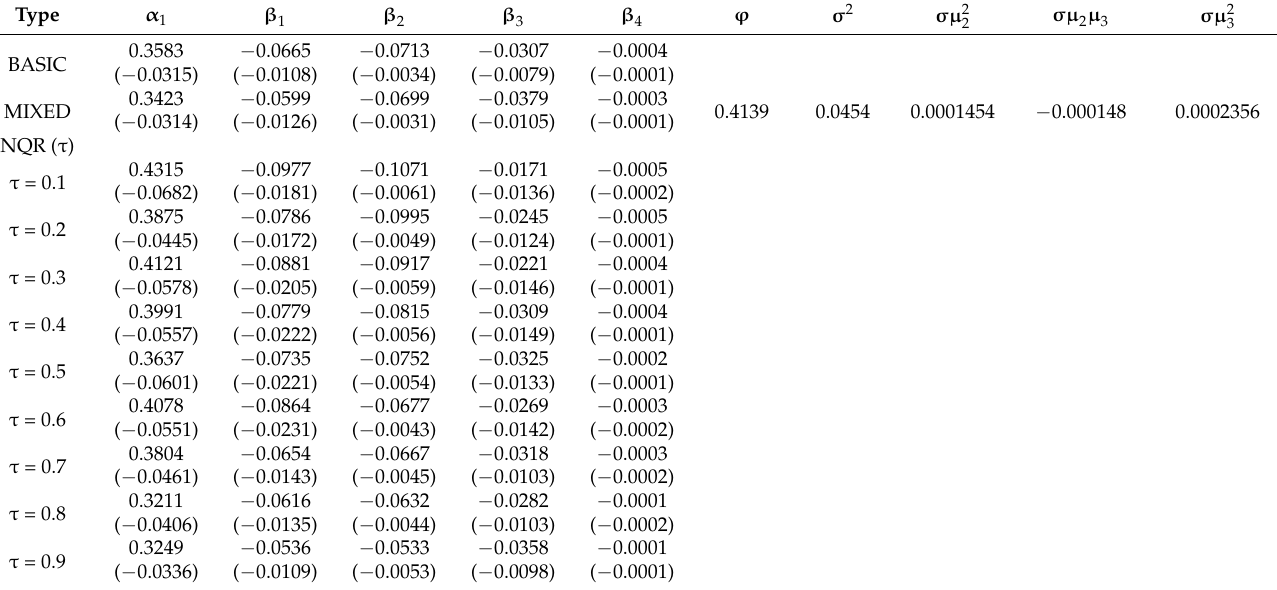
Table A6. Parameter estimates (standard error) of the basic, mixed, and NQR models at different quantiles ( τ ) for CBMF.